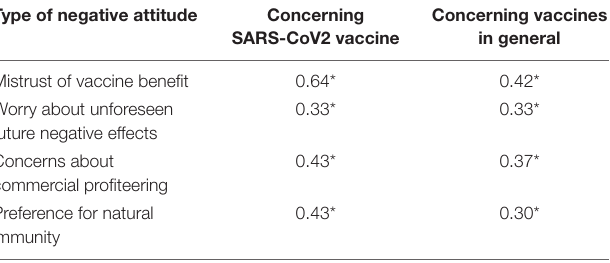
TABLE 1 | Point-biserial correlations between the decision to not get vaccinated against SARS-CoV2 and negative attitudes about a SARS-CoV2 vaccine and vaccines in